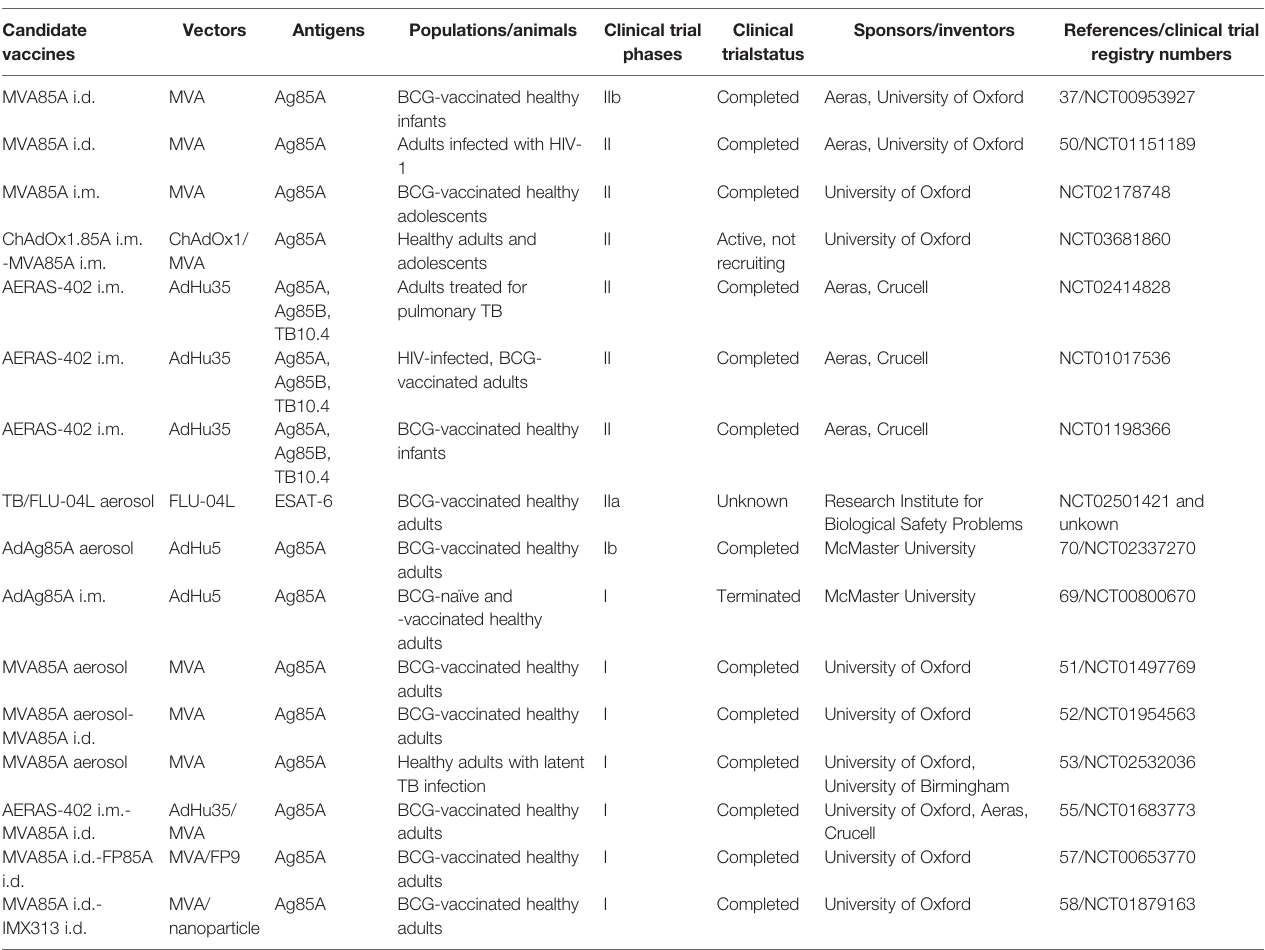
TABLE 1 | Viral vectored TB vaccine candidates that are currently in clinical trials. Candidate